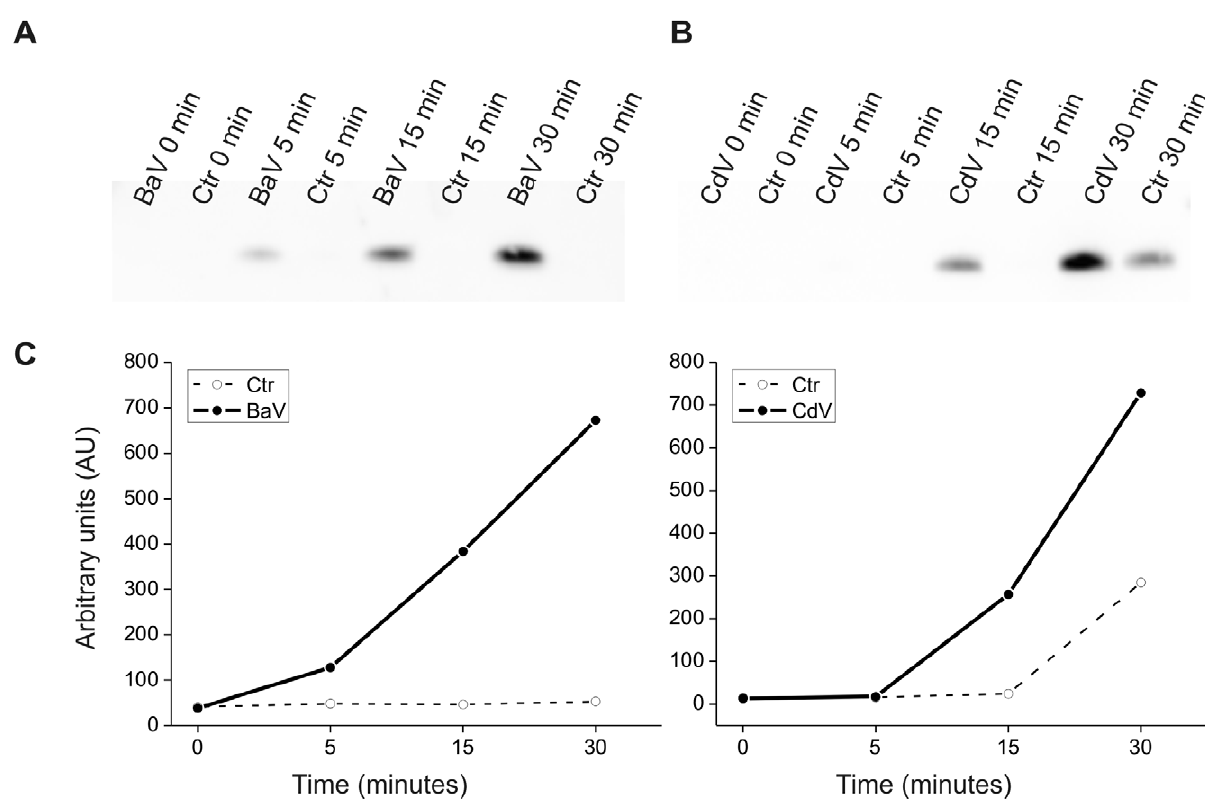
Figure 2. B.asper and C.durissusterrificus venoms induce Cytochrome c release. Time course of Cyt c release from isolated tibialis anterior mice muscles in the incubation medium after addition of BaV (A) or CdV (B). The protein concentrations were determined and 2.5 m g of total proteins were loaded in each lane. Western blots depicting the time course of Cyt c release (A) after BaV treatment (50 m g/ml) or (B) after CdV (50 ug/ml) and the same volume of vehicle as control. (C) The graphs report the quantitative analysis of the kinetics of Cyt c release induced by venoms (black lines) and controls (dotted lines). The intensity of each band was determined using the software Quantity One (Bio-Rad) The blots and their quantification show one representative experiment (n $